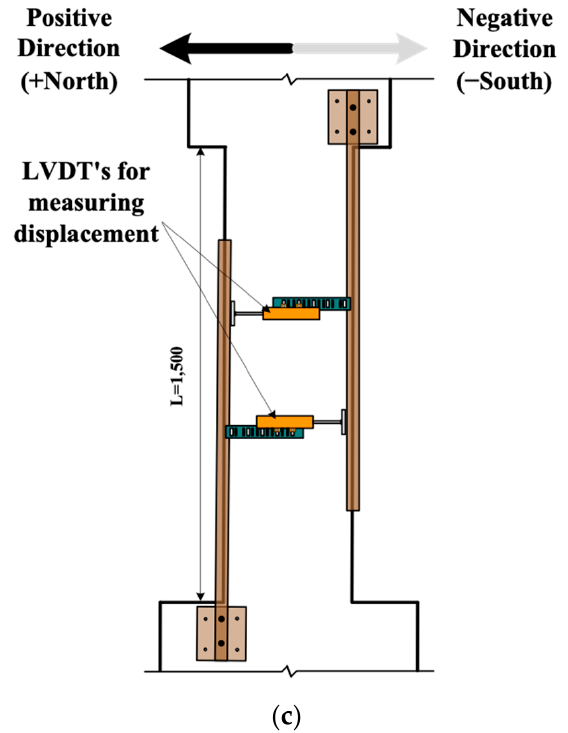
Figure 4. Test setup of specimen: ( a ) View of test setup; ( b ) Loading history; ( c ) Measurement of displacement.